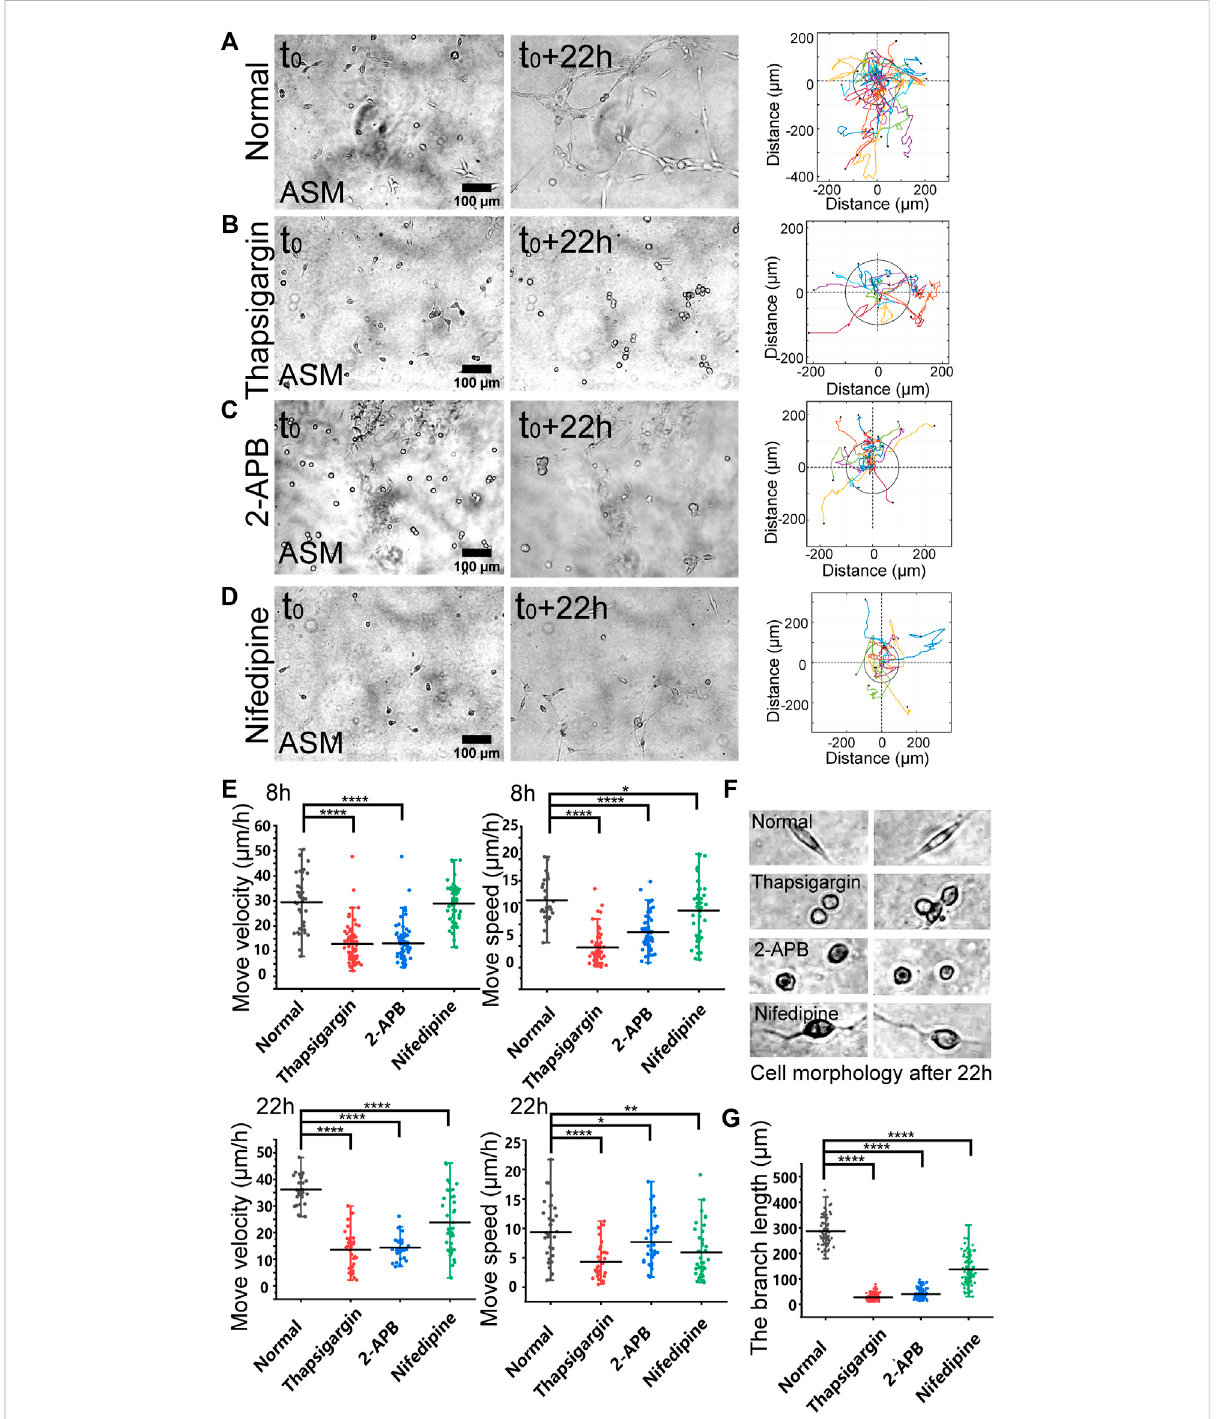
FIGURE 2 Regulations by membrane calcium channels in cell migration and branching assembly. ASM cells were seeded on the hydrogel with or without calcium channelinhibitorintheculture medium. Time-lapse imagingwas takenevery 0.5 hfor 22 h, followed with trajectory analysisand branching quanti fi cation. (A – D) Cell images at 0 and 22 h, and trajectory analysis of cell movements under the control condition (DMSO) (A) , or with thapsigargin (10 µM) (B) , 2-APB (100 µM) (C) , or nifedipine (10 µM) (D) in the medium. (E) Statistical quanti fi cations of cell move velocity and speed with or without the calcium channel inhibitors when culturing on the hydrogel. The sample size n = 46, 55, 34, 36 (velocity) and 56, 55, 34, 35 (speed) for 8 h (top panel), and n = 29, 28, 31, 37 (velocity) and 32, 31, 34, 40 (speed) for 22 h (bottom panel), respectively. In considering that at later time, the cells might have formed branching or clusters and stopped directional migration, so quanti fi cations were performed at 8 and 22 h, respectively. (F) Representative cell morphologies with or without the calcium inhibitors. (G) Statistical quanti fi cations of the branching lengths with or without the calcium channel inhibitors when culturing on the hydrogel for 22 h ( n = 81, 112, 112, 102,